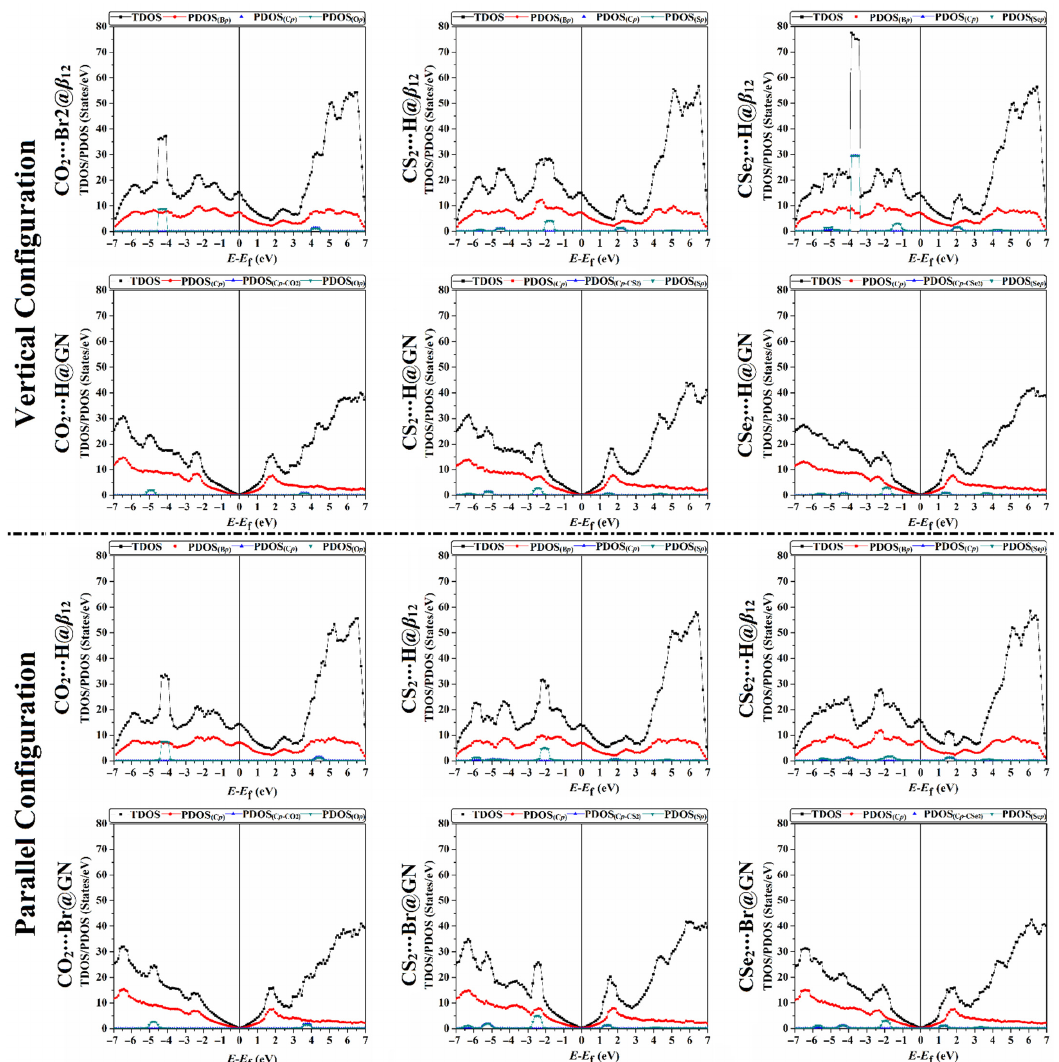
Figure 6. Total and projected densities of states (TDOS/PDOS) for the relaxed structures of the ver- tical and parallel configurations of the CX 2 ∙∙∙ β 12 /GN complexes (where X = O, S, or Se) at the most favorable energetic sites. The contributions of the p -orbital for boron (B), carbon (C), oxygen (O), sulfur (S), and selenium (Se) atoms in the adsorption process are represented by B p , C p , O p , S p , and Se p , respectively. sheets were changed after adsorbing the CX 2 molecules in vertical and parallel configura- tions. The appearance of the new DOS peaks indicated the occurrence of adsorption of the CX 2 molecules on the investigated 2D sheets.